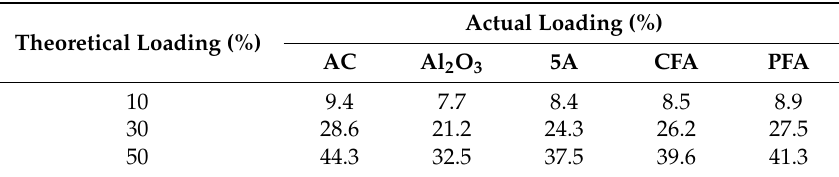
Table 1. Actual loading of different supports.